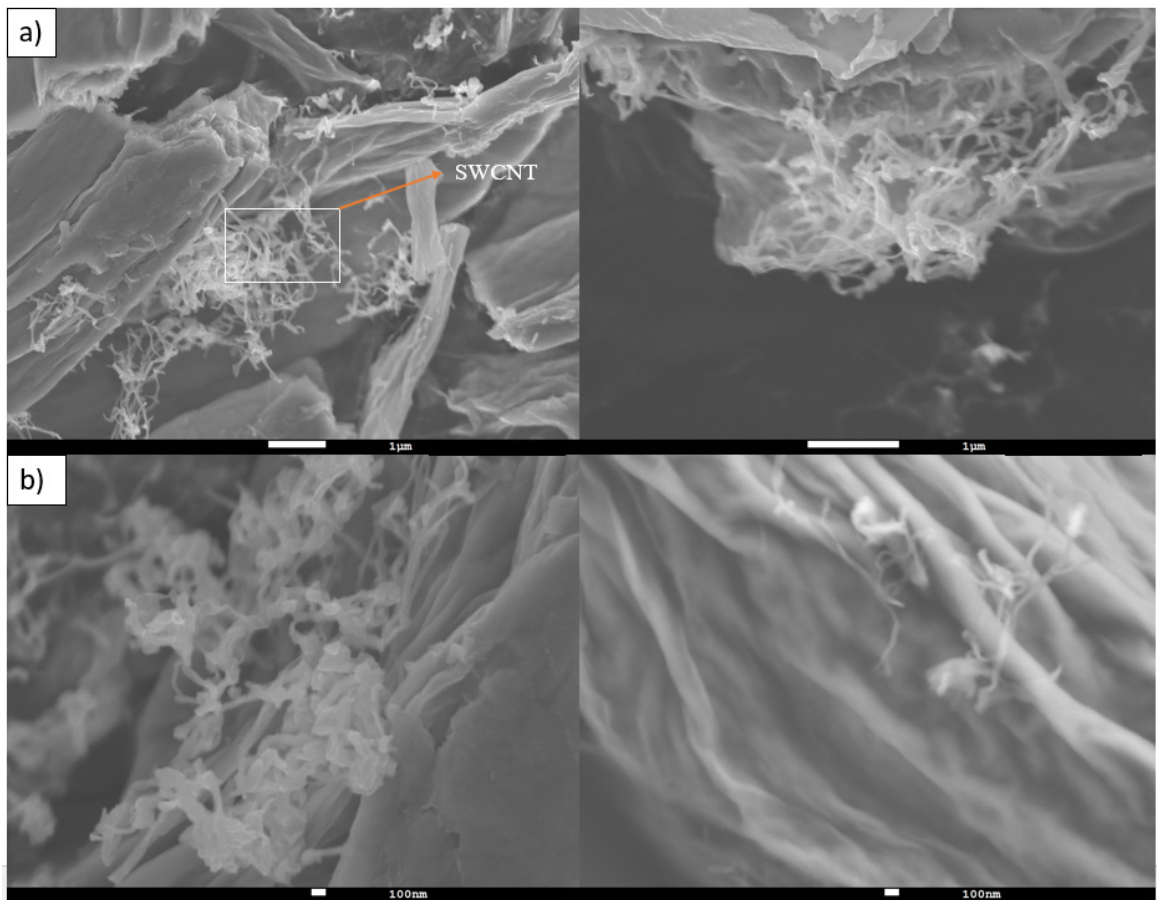
Figure 4. ( a ) The interconnected porous framework of the V 2 O 5 –SWCNT composite materials contains continuous nanopores. ( b ) Porous and rough sheets create a sandwich-like structure with SWCNTs and V 2 O 5 particles.